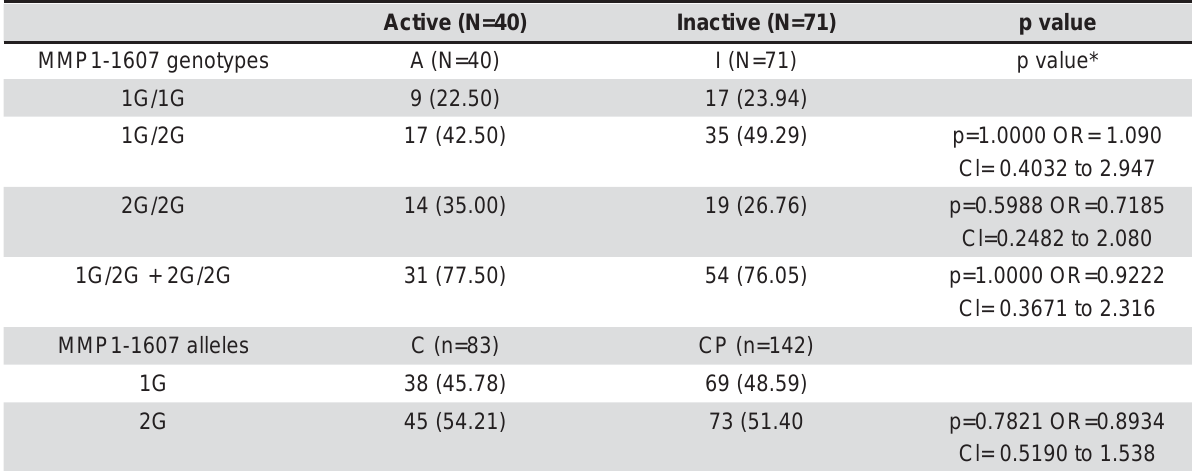
Table 2- Frequencies of MMP1-1607 SNP in patients presenting active and inactive periapical lesions